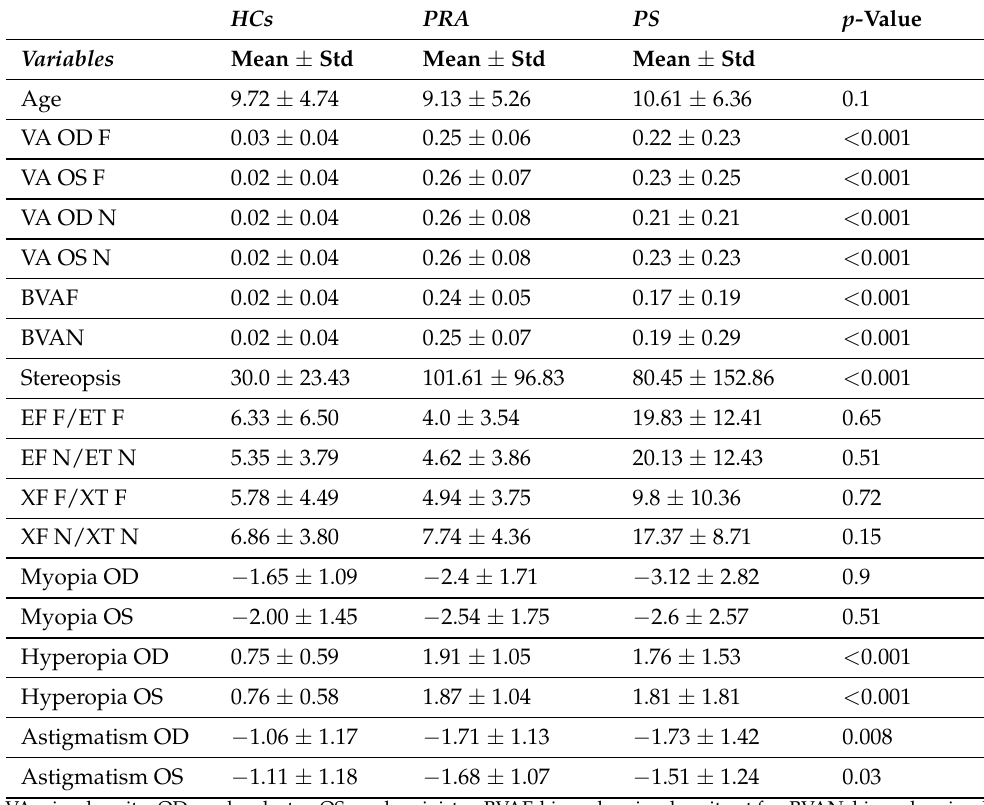
Table 1. Descriptive statistics of the variables analyzed in this study.